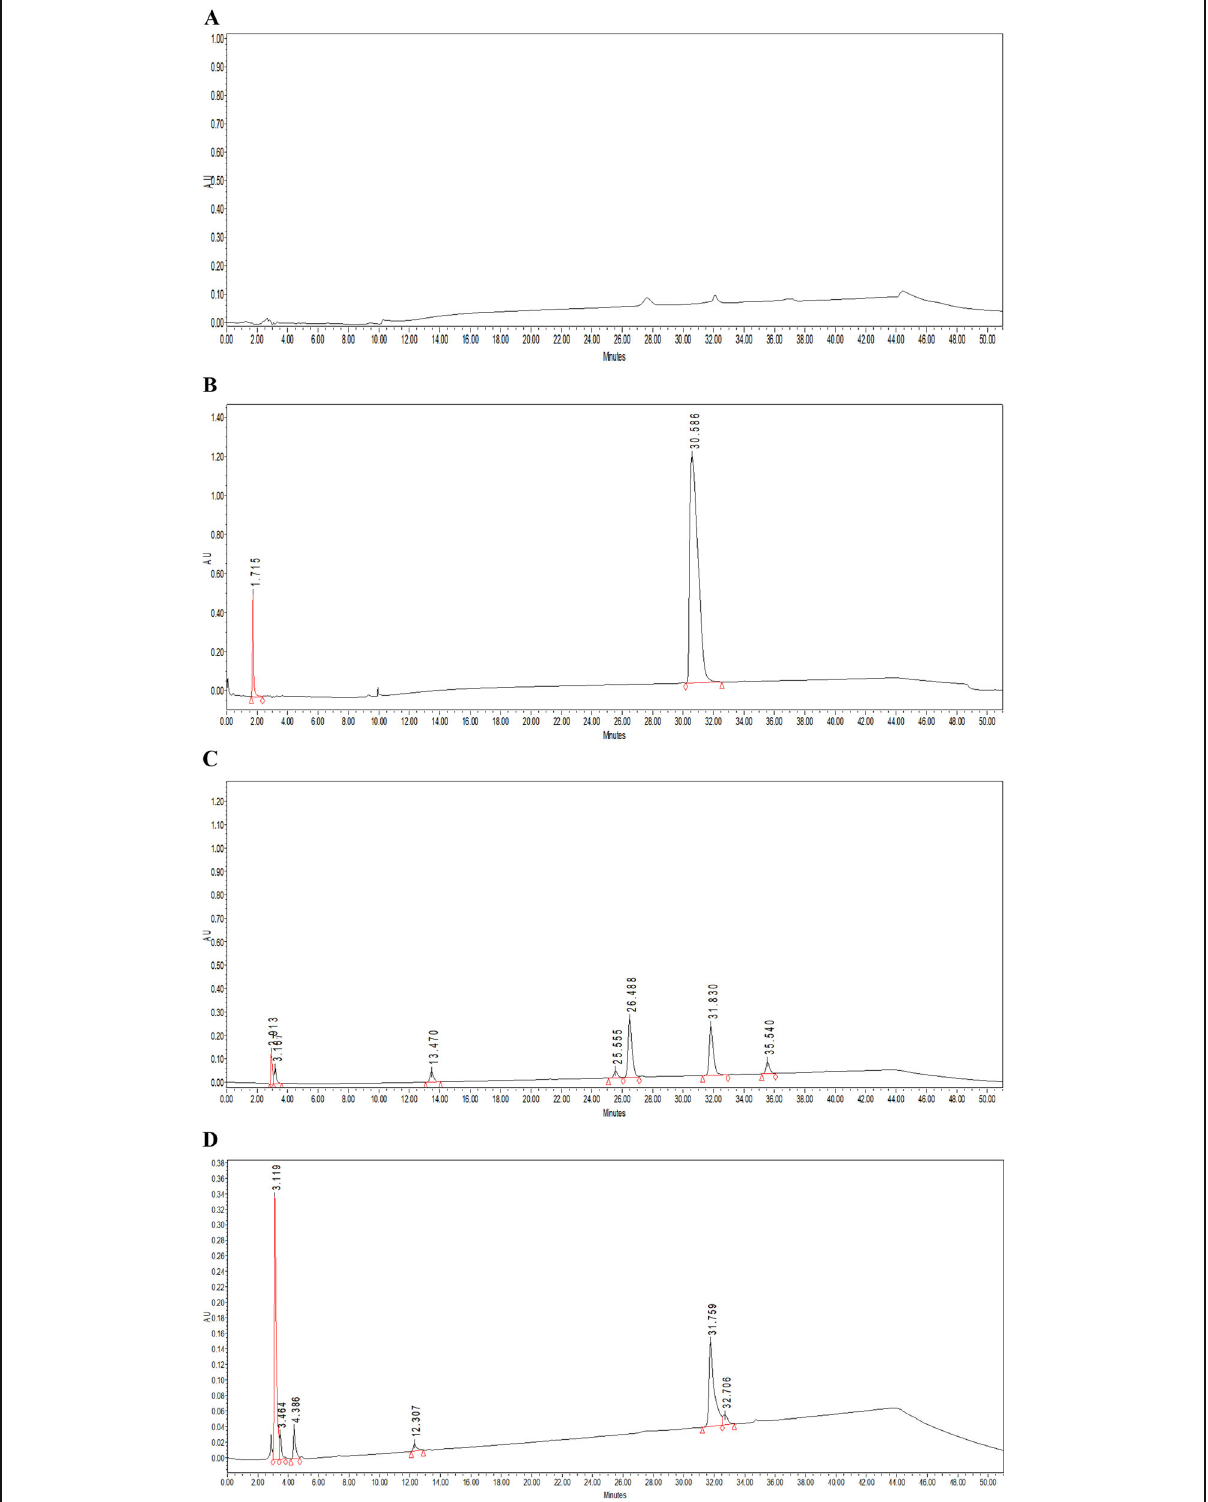
Fig. 2 a Blank chromatogram. b Blank added with bedaquiline API. c Acid-treated bedaquiline. d Alkali-treated